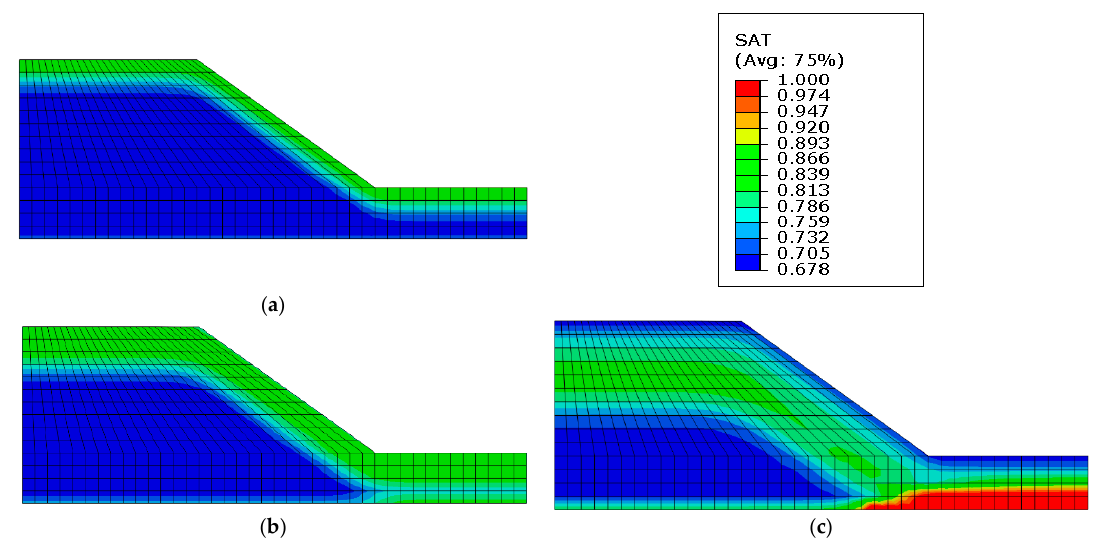
Figure 5. Variations of saturation in the FE infiltration analysis: ( a ) t = 10.6 h; ( b ) t = 20.2 h; ( c ) t = 40 h.